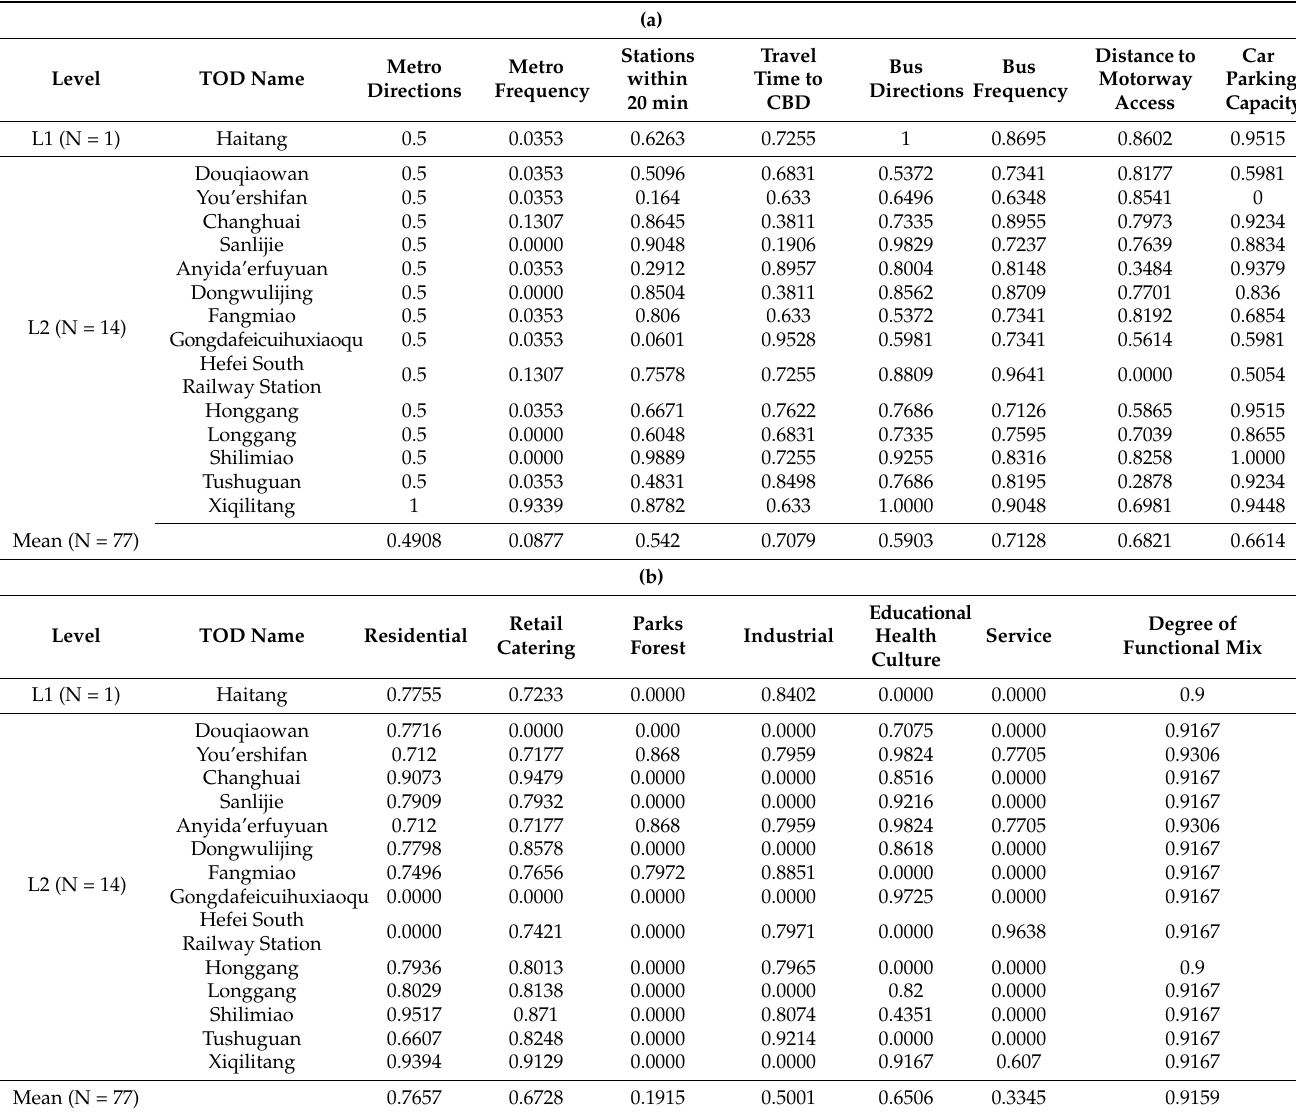
Table 3. ( a ) Detailed description of 15 priority TODs (node-value). ( b ) Detailed description of 15 priority TODs